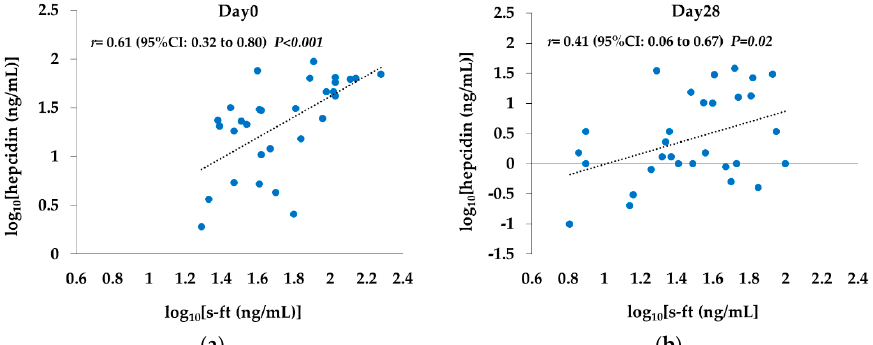
Figure 5. Correlation between s-ft and hepcidin levels . ( a ) Day 0: Log 10 (s-ft) and Log 10 (hepcidin) showed a significant positive correlation ( r = 0.61 [95% CI: 0.32 to 0.80; p < 0.01]). ( b ) Day 28: The correlation was weaker compared with Day 0 ( r = 0.41 [95% CI: 0.06 to 0.67; p = 0.02]). The Pearson product-moment correlation coe ffi cient and univariable linear regression model were